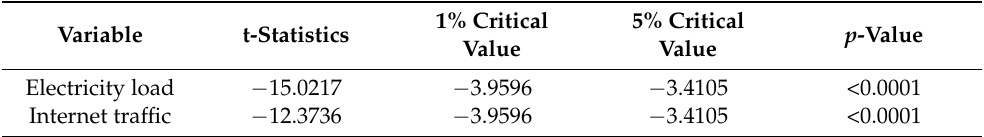
Table 5. Augmented Dickey–Fuller (ADF) test of log-transformed Electricity Load and Internet traffic